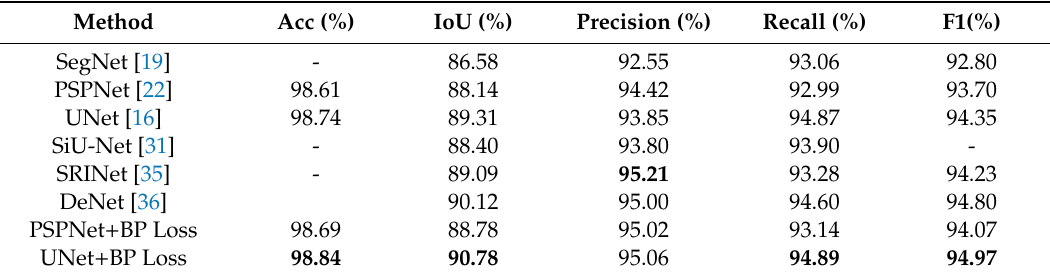
Table 5. SOTA comparisons on the WHU dataset.